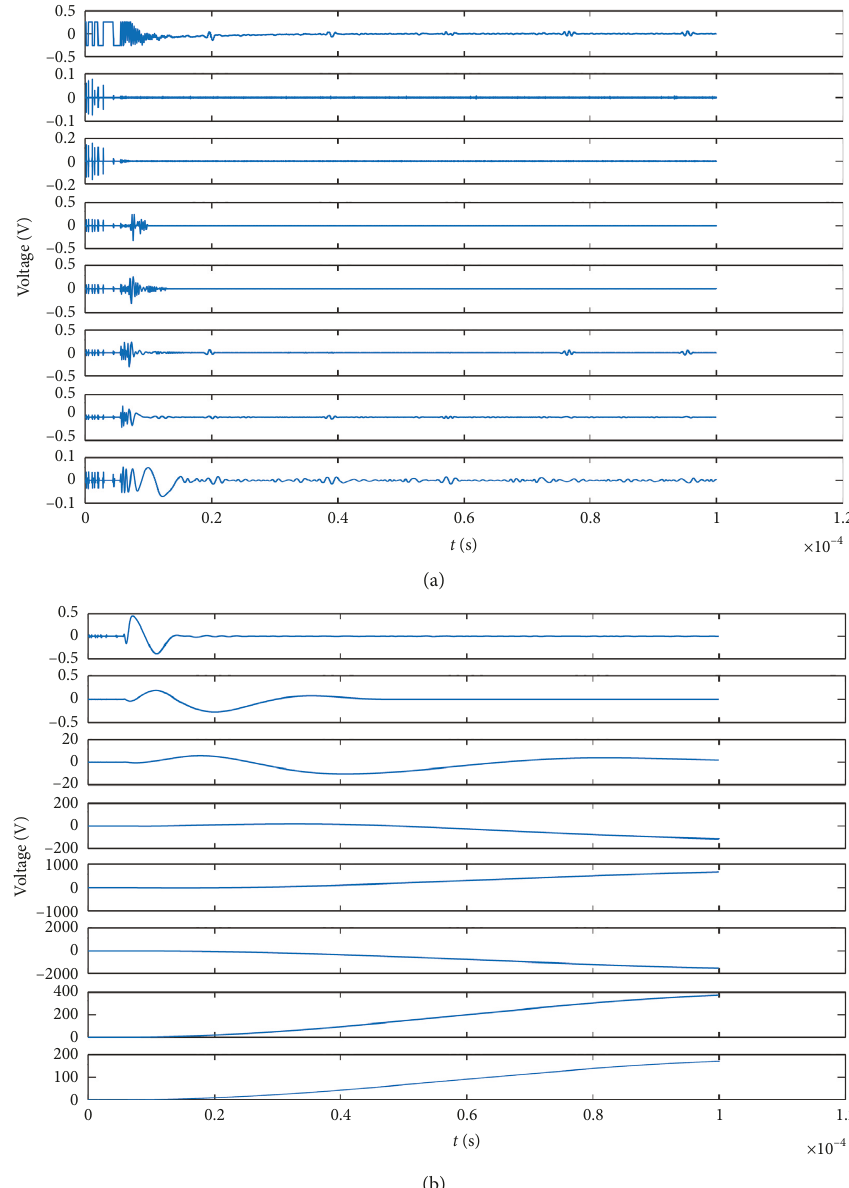
Figure 5: IMFs obtained by the improved method. (a) IMF 1–8. (b) IMF